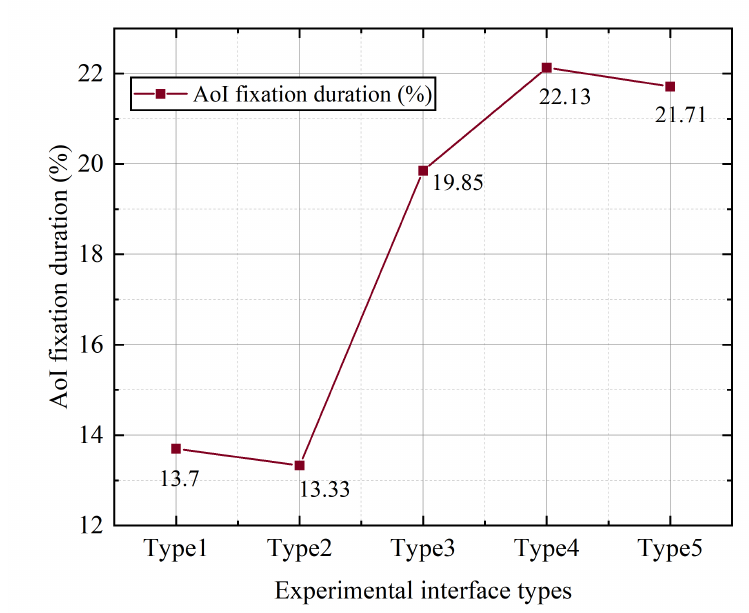
Figure 10. The average value of the ratio of the gaze duration of the buttons of different sizes.